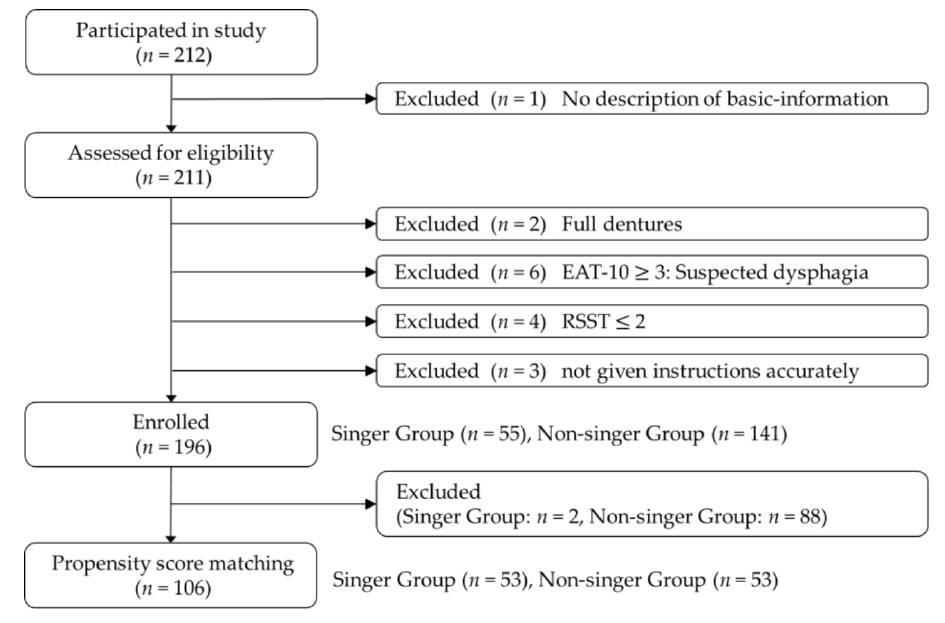
Figure 1. Flow diagram summarizing study selection criteria. Table 1. Full Cohort Demographic and Clinical